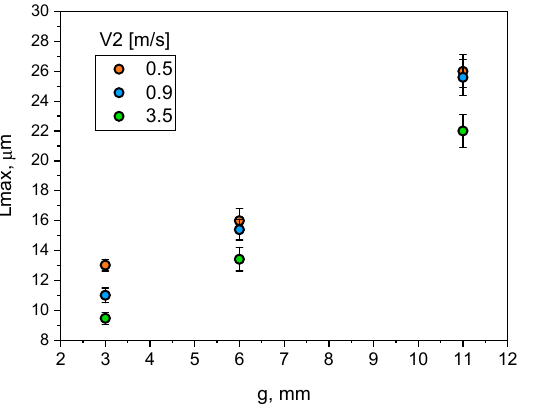
Figure 13. Influence of wall thickness and plunger velocity ( V 2 ) on maximum size of silicon particles ( L max ).